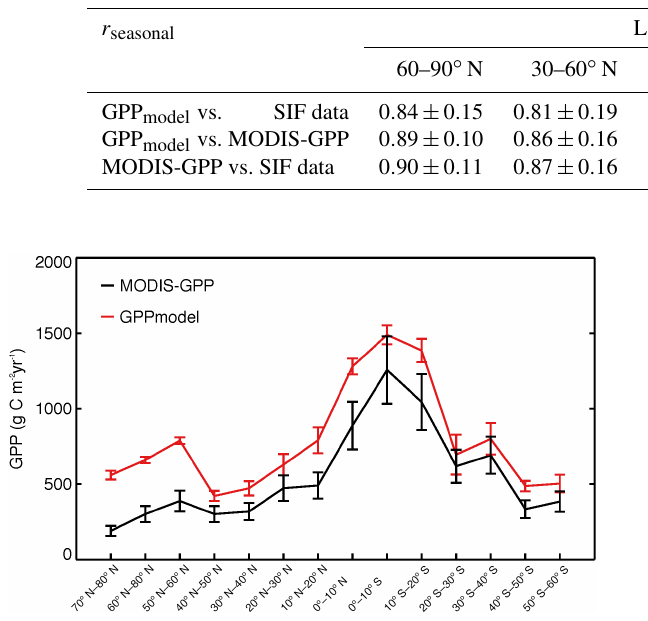
Figure 8. Comparison between mean MODIS-GPP and modelled GPP for the period 2000–2013 by latitude band. The uncertainty of MODIS-GPP comes from the reported relative error term driven by NASA’s Data Assimilation Office (DAO) reanalysis datasets (Zhao et al., 2006). The uncertainty of modelled GPP is the standard devi- ation of interannual variation of grassland GPP in each band for the period 2000–2013.